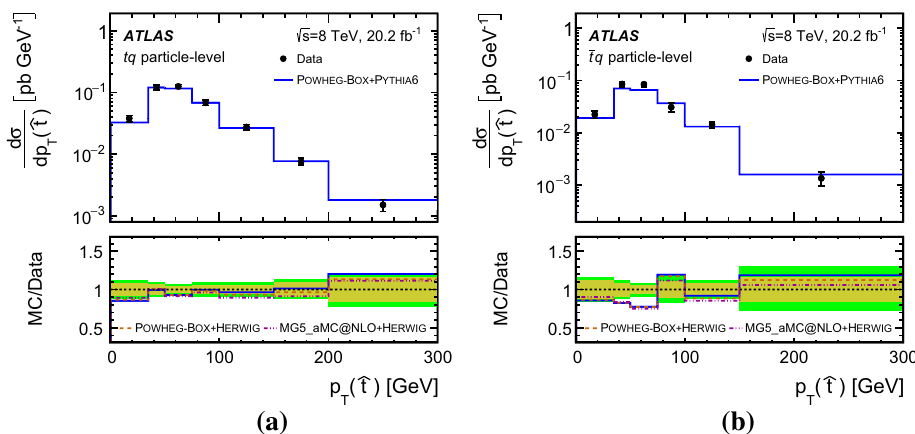
Fig. 17 Absolute unfolded differential cross-sections as a function of p T ( ˆ t ) for a top quarks and b top antiquarks. The unfolded distributions are compared to various MC predictions. The vertical error bars on the